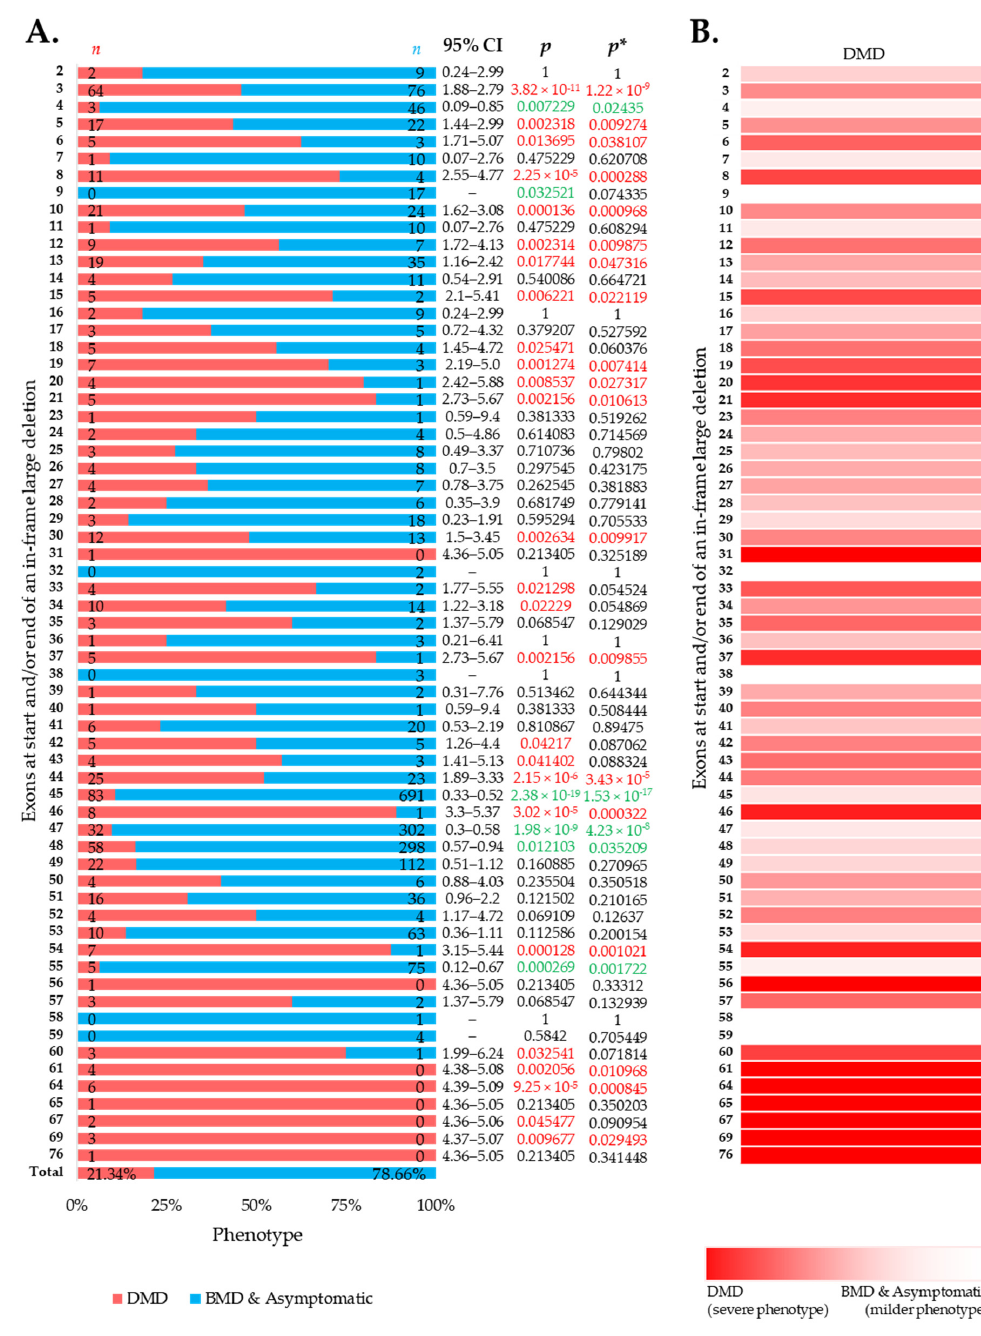
Figure 2. Clinical phenotypes of exon skip-equivalent in-frame DMD exon deletions. ( A ) Association between in-frame deletions starting and/or ending at each exon (exon skip-equivalent) and consequent phenotypes. Phenotypic ratios associated with in-frame deletions starting and/or ending at a given exon and all other exons were compared using Fisher’s exact test. n indicates the number of individuals with DMD (red) and milder (blue; BMD and asymptomatic) phenotypes. Green and red color indicate a significantly lower and higher incidence of DMD phenotype for a given exon, respectively, as compared to the overall incidence rate. p = p -value, as calculated by Fisher’s exact test; p * = Benjamini–Hochberg adjusted p -value. ( B ) Heatmap showing the relative severity of the consequence of in-frame deletions starting and/or ending at specific exons.